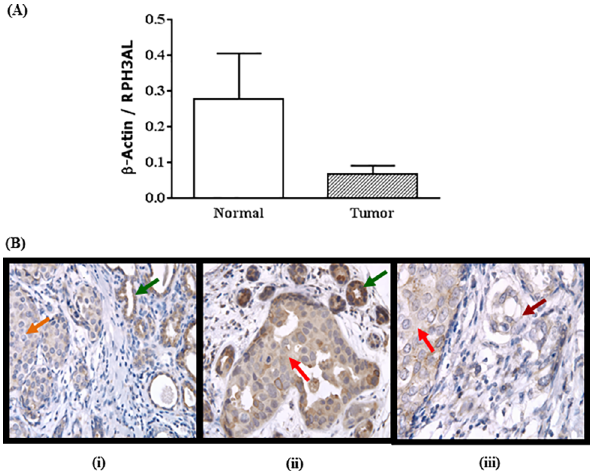
Fig 1. Down-regulation of RPH3AL mRNA and protein in breast cancers. Analyses of mRNA and protein expression of RPH3AL (A) mRNA levels of RPH3AL down-regulated in breast cancers relative to their matching normal tissues. (B) Immunohistochemical staining of RPH3AL in breast cancer tissues. RPH3AL expression was seen predominantly in the cytoplasm of (i) lobular intraepithelial neoplasia (LIN, orange arrow) and adjacent normal cells (green arrow) (X100) (ii) ductal carcinoma in situ (DCIS, red arrow) and adjacent normal cells (green arrow) (X100) (iii) DCIS (red arrow) and invasive carcinoma (dark red) (X200). LIN and DCIS exhibit lower expression of RPH3AL relative to adjacent normal cells. Mild nuclear staining was also seen in a few cells of normal, LIN, DCIS, and invasive carcinoma.